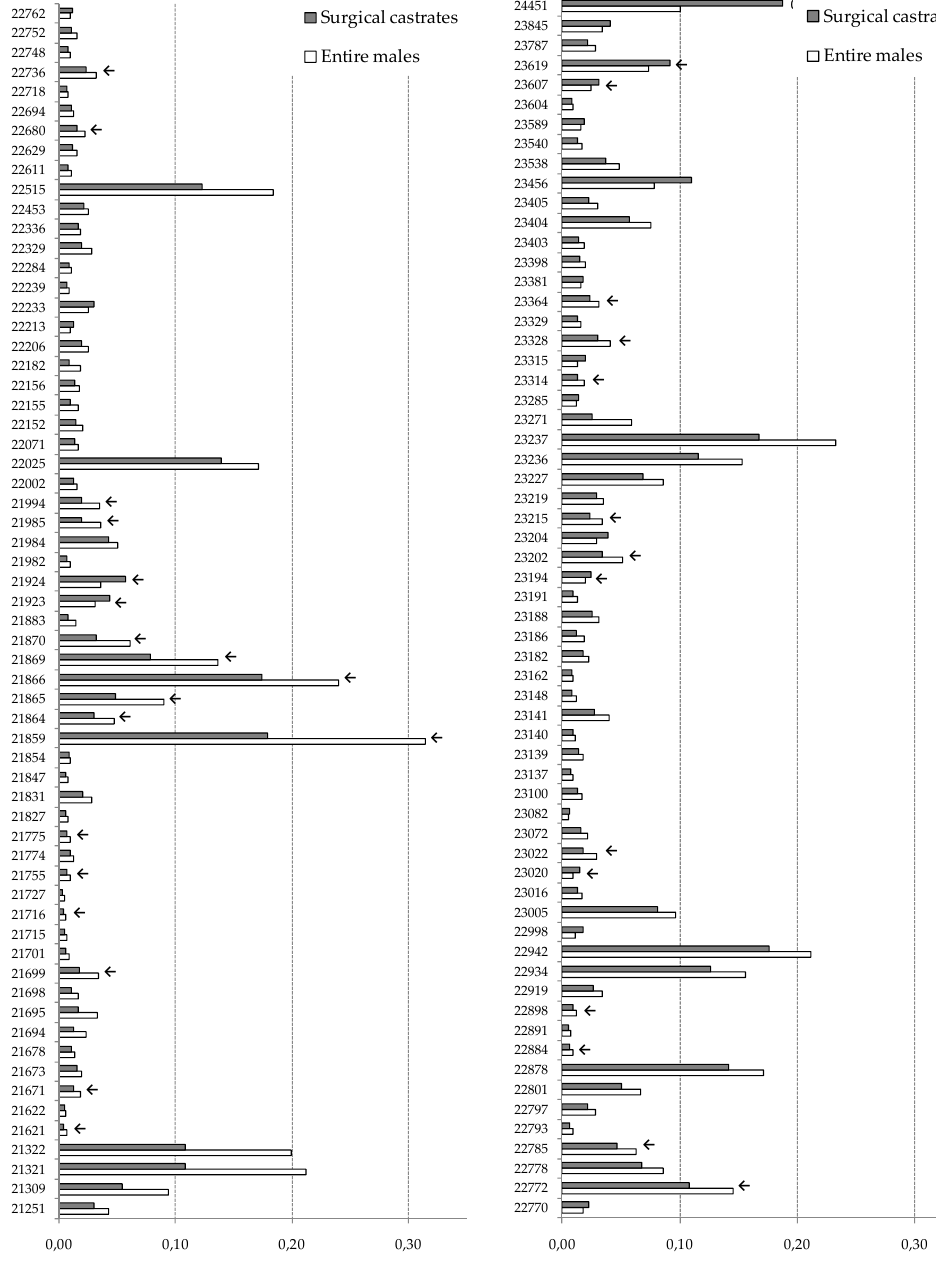
Figure 1. Relative abundancies (vol%) of the protein spots significantly differing ( p < 0.05) between surgical castrates and entire males. The numbers corresponding to the relative abundancies represent the protein identification; the ones indicated by an arrow were identified by mass spectrometry.